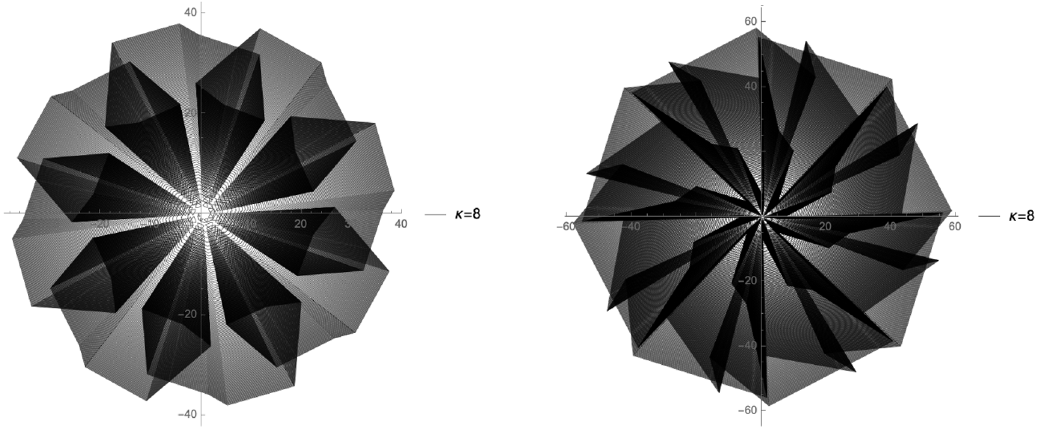
Figure 5 . Plot of Z p 0 : 03 + i 0 : 1. Right: m = 0 : 1 + i